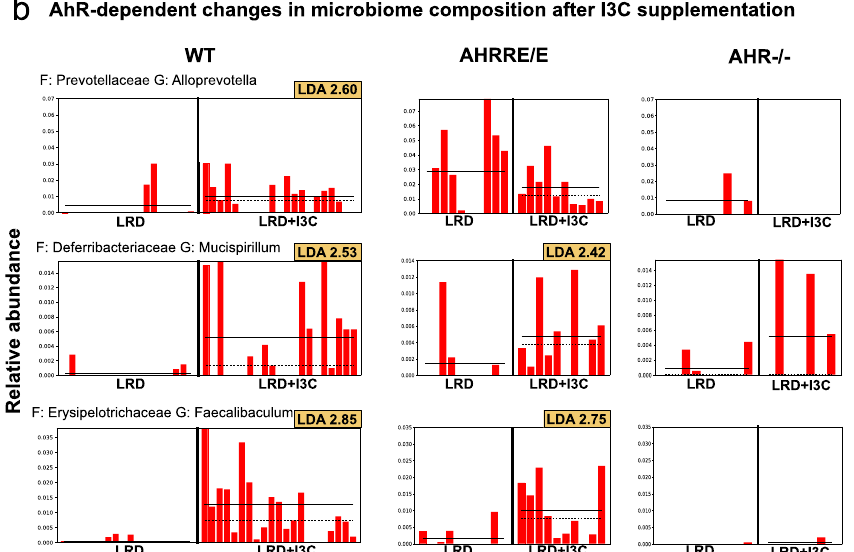
Figure 6. Selection of discriminative biomarkers that are detected by linear discriminant analysis (LDA) coupled with e ff ect size measurements (LEfSe) analysis. Frequencies of biomarkers showing ( a ) AhR-independent changes in microbiome composition after I3C supplementation. Relative abundance of Escherichia-Shigella ( Enterobacteriaceae ), Clostridiales ( Clostridia ), Rikenellaceae ( Bacteriodales ), and Muribaculaceae ( Bacteroidales ) are shown. ( b ) AhR-dependent changes in microbiome composition in WT, AhRR E / E , and AhR − / − mice fed LRD or LRD + I3C. Relative abundance of Alloprevotella ( Prevotellaceae ), Mucispirillum ( Deferribacteriaceae ), and Faecalibaculum ( Erysipelotrichiaceae ) are presented. Horizontal solid lanes represent the mean, and horizontal dashed lines represent the median of relative abundance of the species. LDA values are depicted in the figures.